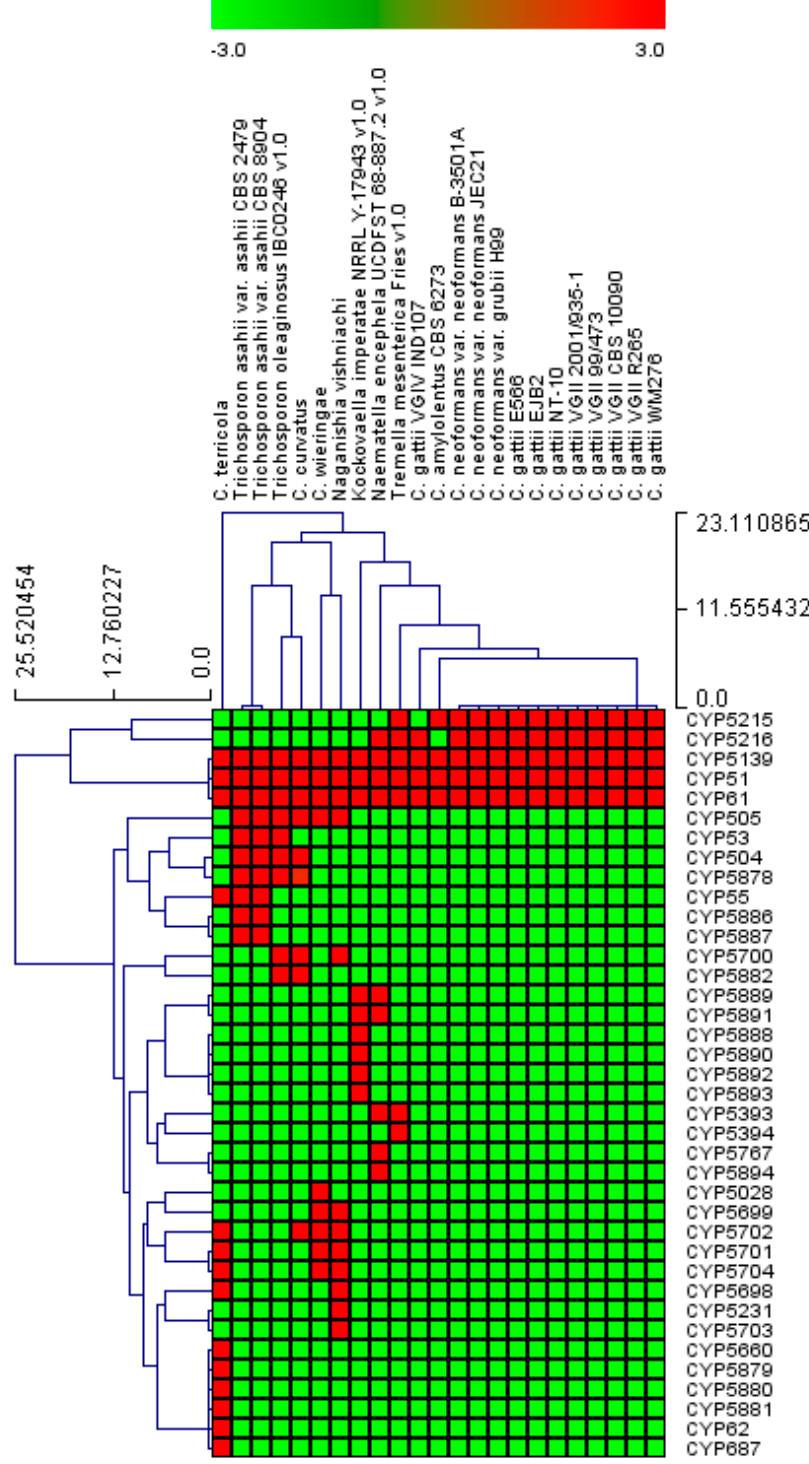
Figure 4. Heat map representing the presence or absence of cytochrome P450 families in 23 species of Tremellomycetes . The data have been represented as –3 for gene absence (green) and 3 for gene presence (red). Twenty-three species of Tremellomycetes form the horizontal axis and CYP families form the vertical axis. The data used in the generation of Figure 4 are presented in Supplementary Dataset 2, sheet 2.